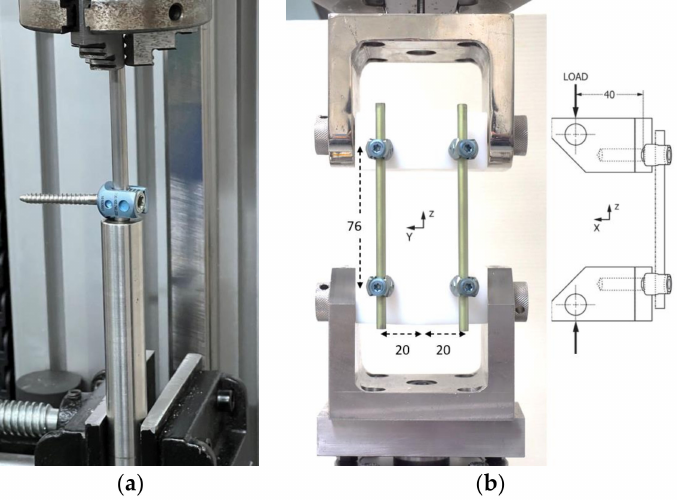
Figure 2. ( a ) Setup of axial gripping capacity (AGC) testing. ( b ) Setup of dynamic mechanical